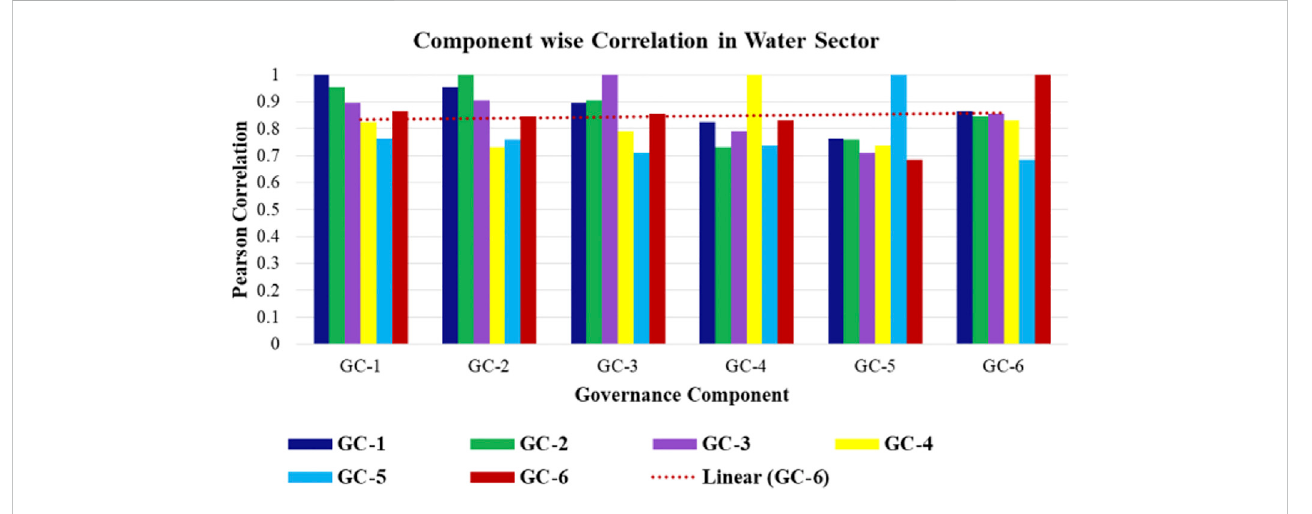
FIGURE 8 Correlations among governance components in the water sector.